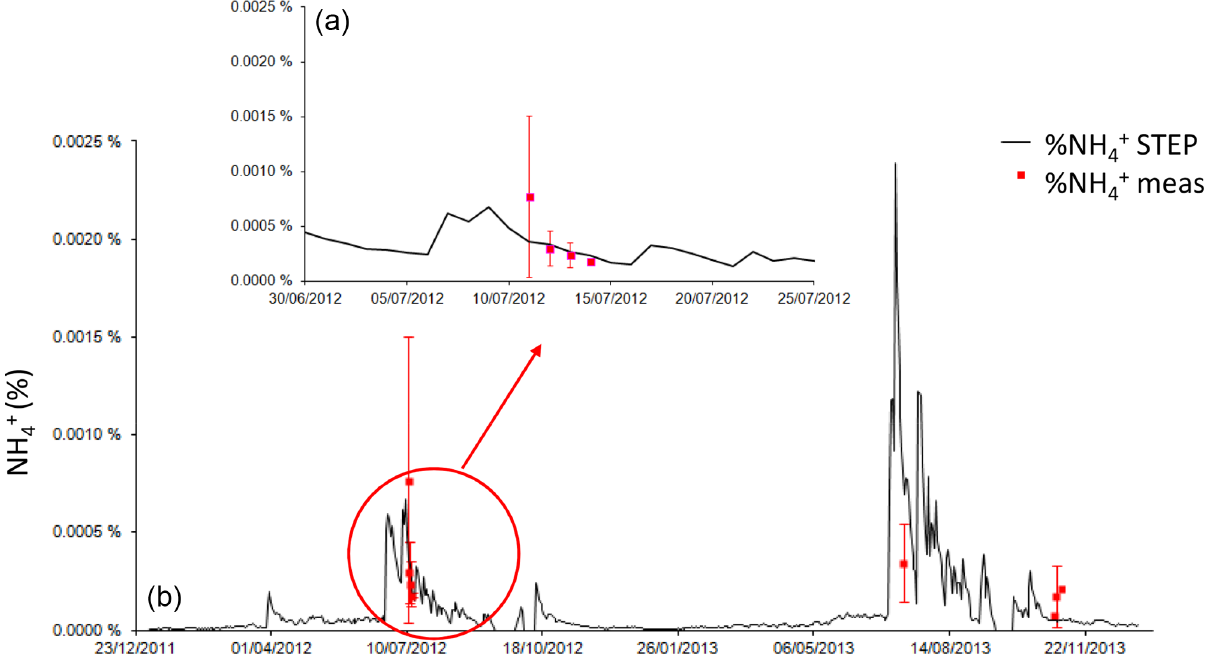
Figure 6. Daily ammonium simulated by STEP–GENDEC (%, black line) and daily averaged ammonium measurement (red squares) during the field campaigns. Error bars in red give the standard deviation at the daily scale for measurements. The upper panel is a focus of